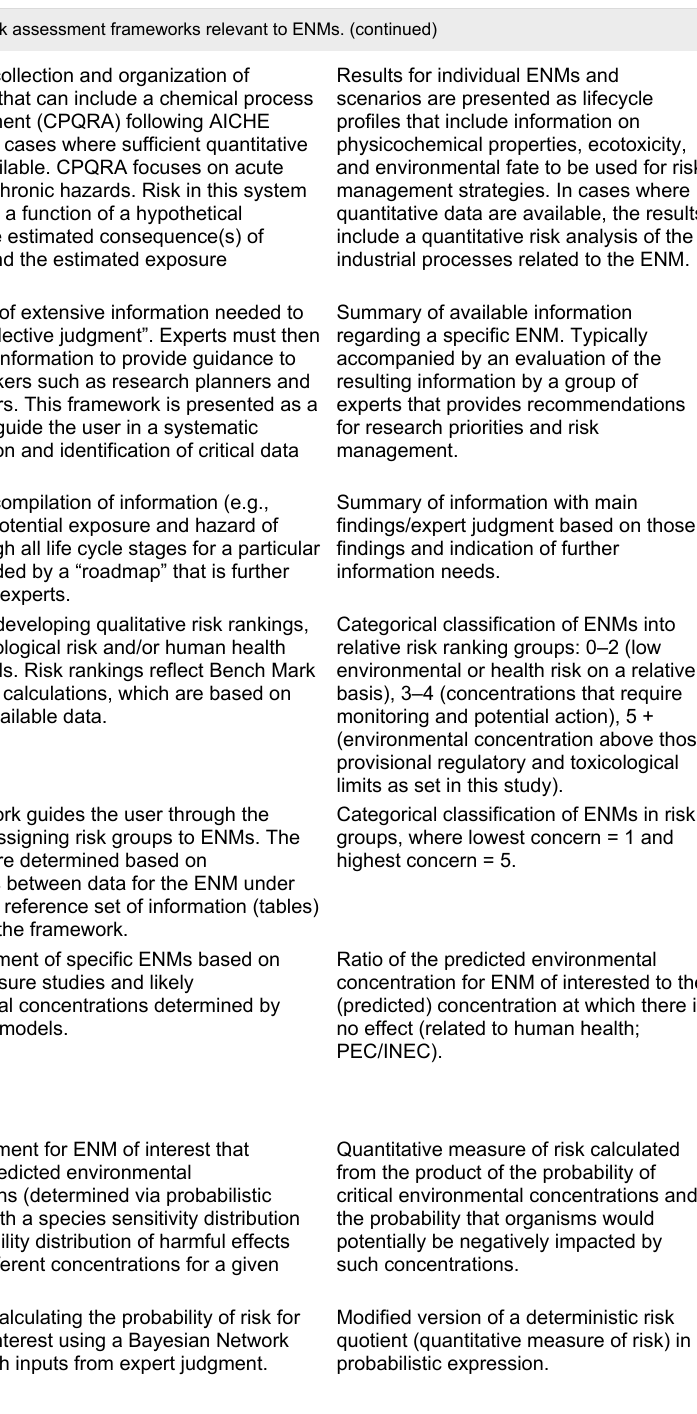
Table 1: Summary of critical characteristics of existing risk assessment frameworks relevant to ENMs. (continued) DUPONT’s Nanorisk [41] (Environmental Defense Fund (NGO) and DuPont